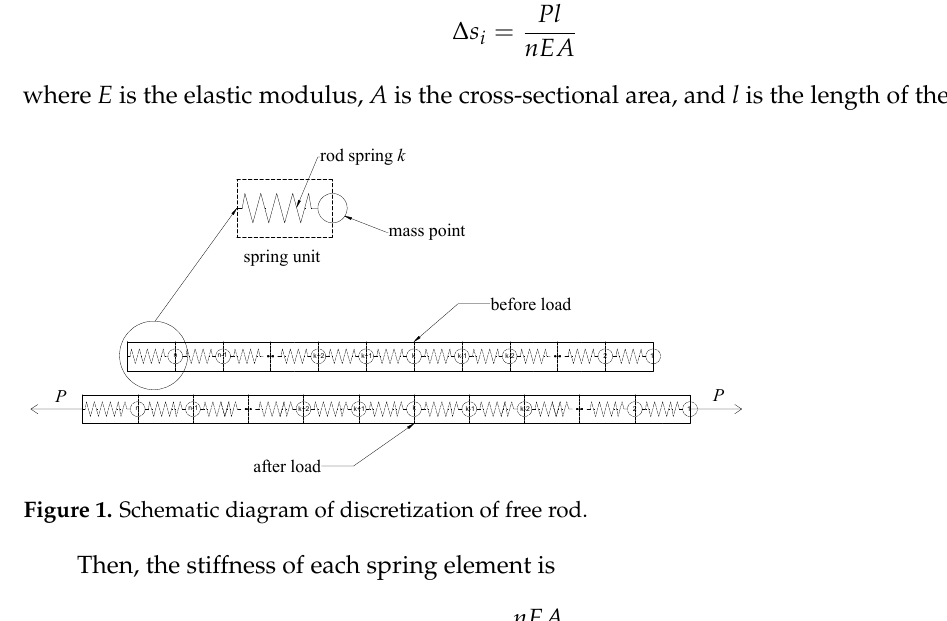
Figure 2. Schematic diagram of discretization of anchor.